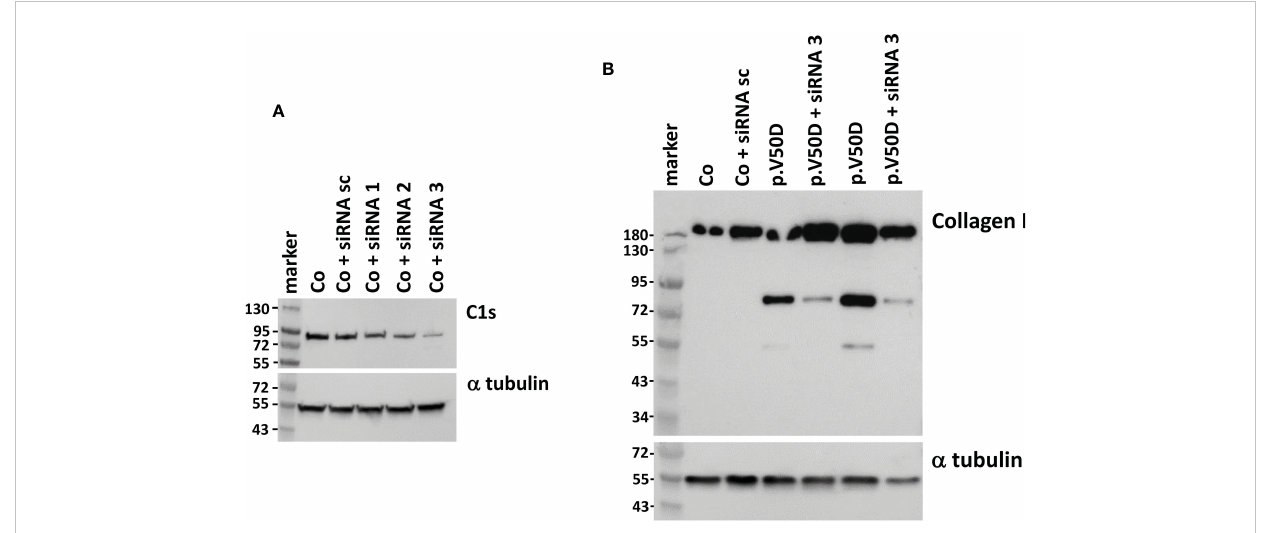
FIGURE 4 Western blot analysis of C1s and collagen I in human fi broblasts with and without C1S knock-down. (A) Transfection of the same control fi broblast with different C1S -directed siRNAs identi fi es siRNA3 as the one that causes the strongest reduction of C1s expression. (B) siRNA3 transfection of pEDS fi broblasts leads to marked reduction of 72 kDa and 55 kDa collagen fragments, con fi rming C1s as cause for collagen I digestion in patient cells. Data are representative of three independent